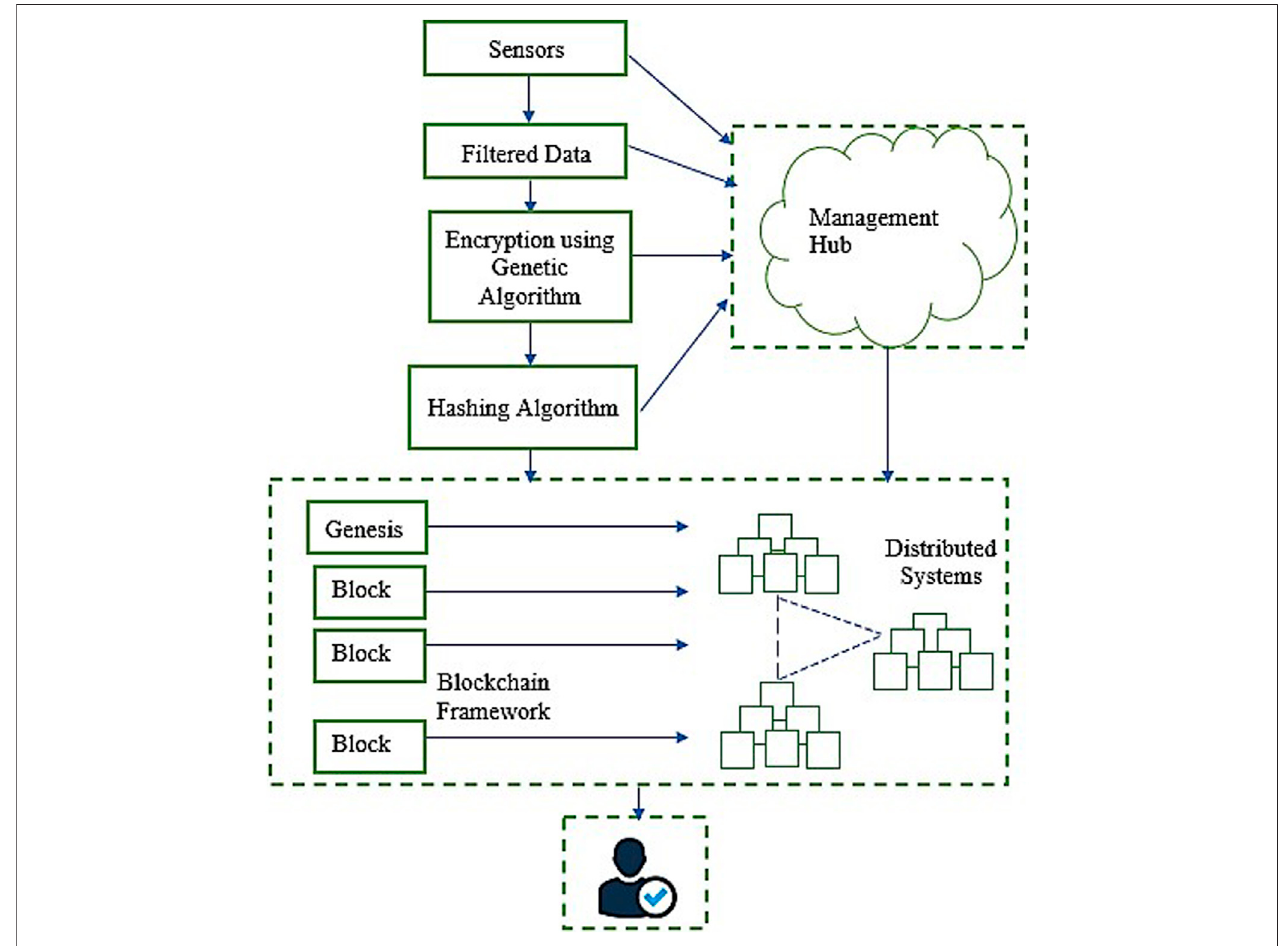
FIGURE 2 | Blockchain